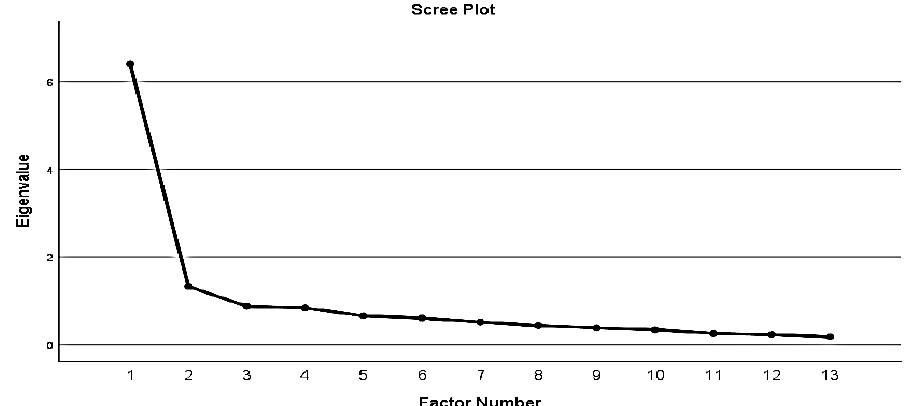
Table 5. Pattern matrix a.